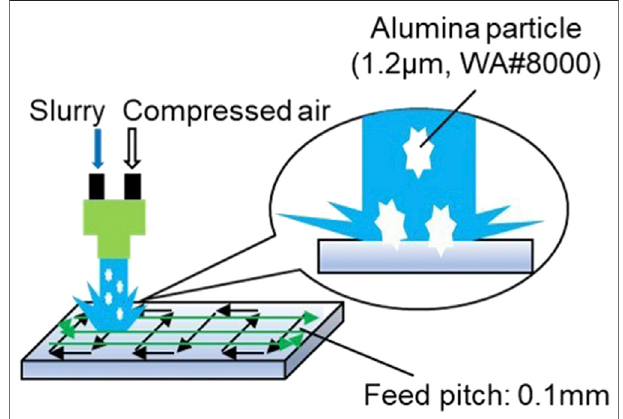
FIGURE 3 | MSJ processing and movements of the injection nozzles.